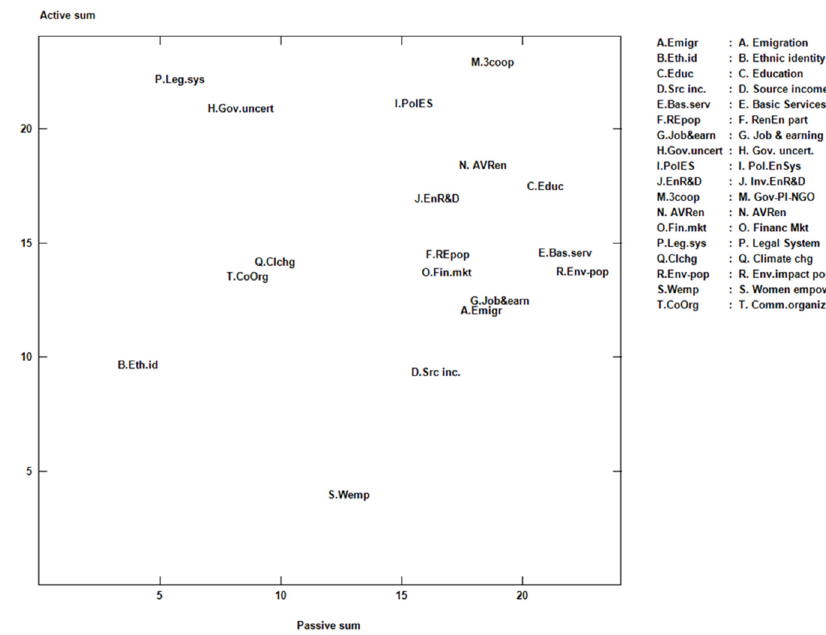
Figure 6. Active–passive positions of the descriptors.